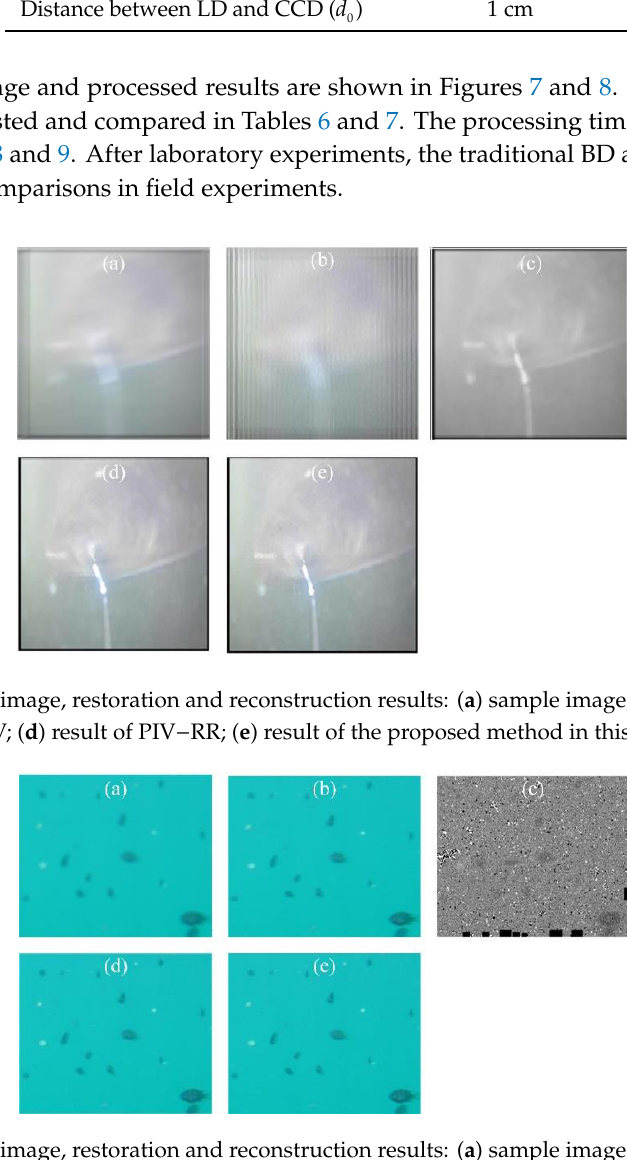
Table 7. Comparison of algorithm running time (min).